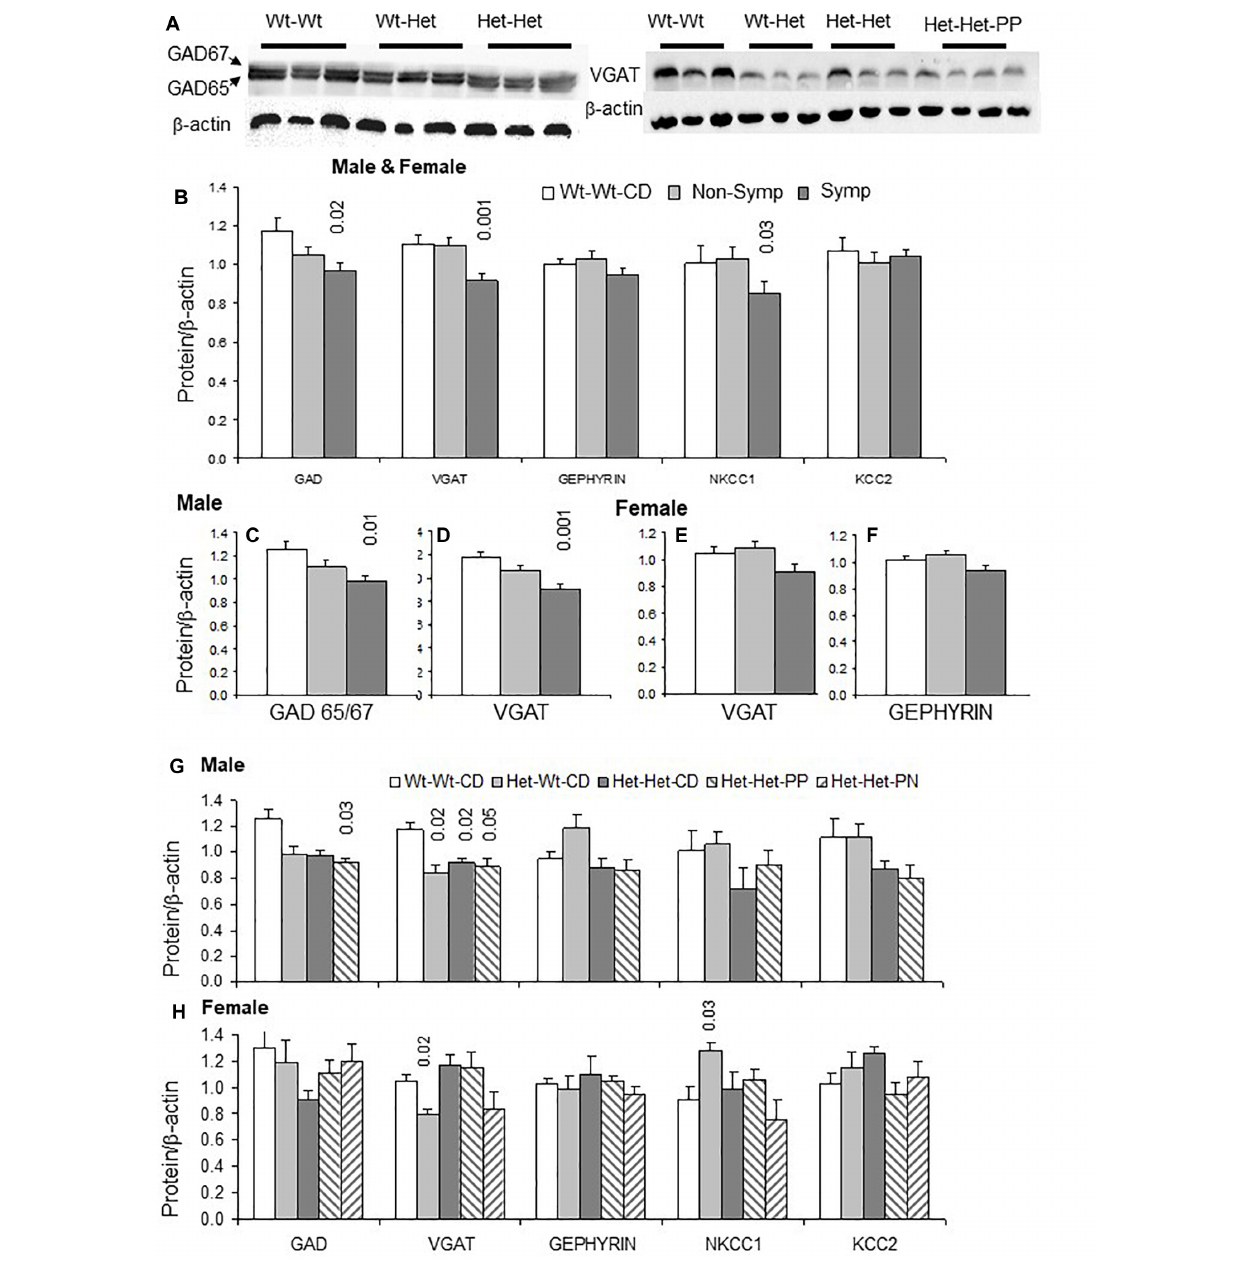
FIGURE 2 | GABA pathway proteins in the cerebral cortex: Effects of maternal and offspring genotypes, diet, sex and behavioral phenotype on protein levels. (A) Contains examples of GAD65/67 and VGAT blots. GABA pathway protein levels normalized to beta-actin levels in all mice presented by behavioral categories (B) and segregated by sex, showing GAD65/67 and VGAT in males (C,D) and VGAT and gephyrin in females (E,F) . N, Male, Wt-Wt-CD, 8; Non-Symptomatic, 16; Symptomatic, 8. N, Female, Wt-Wt-CD, 11; Non-Symptomatic, 25; Symptomatic, 9. Analysis by experimental group in males (G) and females (H) . N, Male, Wt-Wt-CD, 8; Wt-Het-CD, 5; Het-Het-CD, 7; Het-Het-PP, 6. N, Female, Wt-Wt-CD, 9; Wt-Het-CD, 7; Het-Het-CD, 9; Het-Het-PP, 9; Het-Het-PN, 6. P -value in the figure refers to the difference obtained by a one-way ANOVA post hoc test compared to the Wt-Wt-CD group. Additional values for (G) : VGAT Wt-Het-CD vs. Het-Het-CD 0.006; (B) : non-symptomatic vs. symptomatic VGAT- 0.003 and NKCC1- 0.04; (D) : 0.02; and (F) : 0.04. In all other post hoc tests, significant differences were found only when compared to the Wt-Wt-CD group, as indicated in the figure. Data are presented as mean ± SEM.